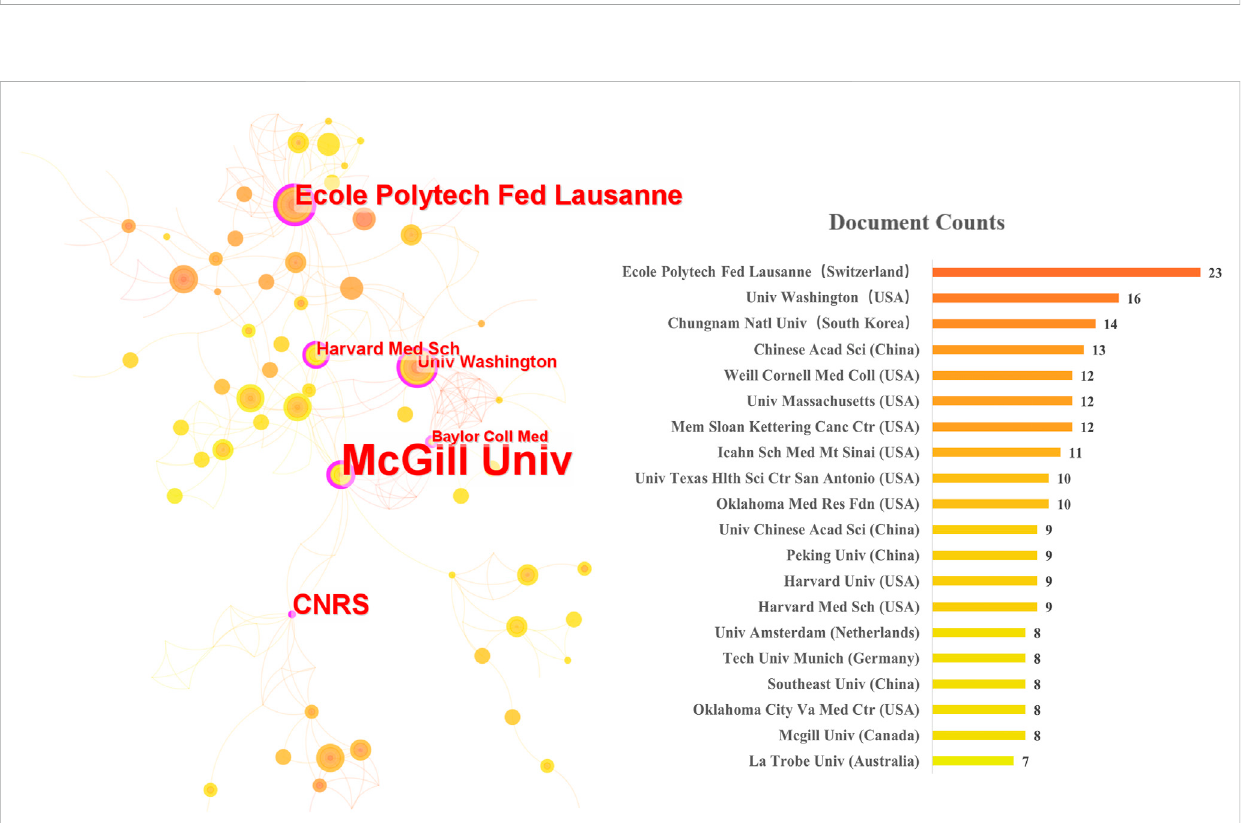
hotspots and rising frontiers over time (Pei et al., 2022). The strongest and earliest citation burst was “ molecular chaperone, ” with a score of 5.54. And the latest one was “ differentiation factor 15, ” which means an emerging research direction (Figure 5B).